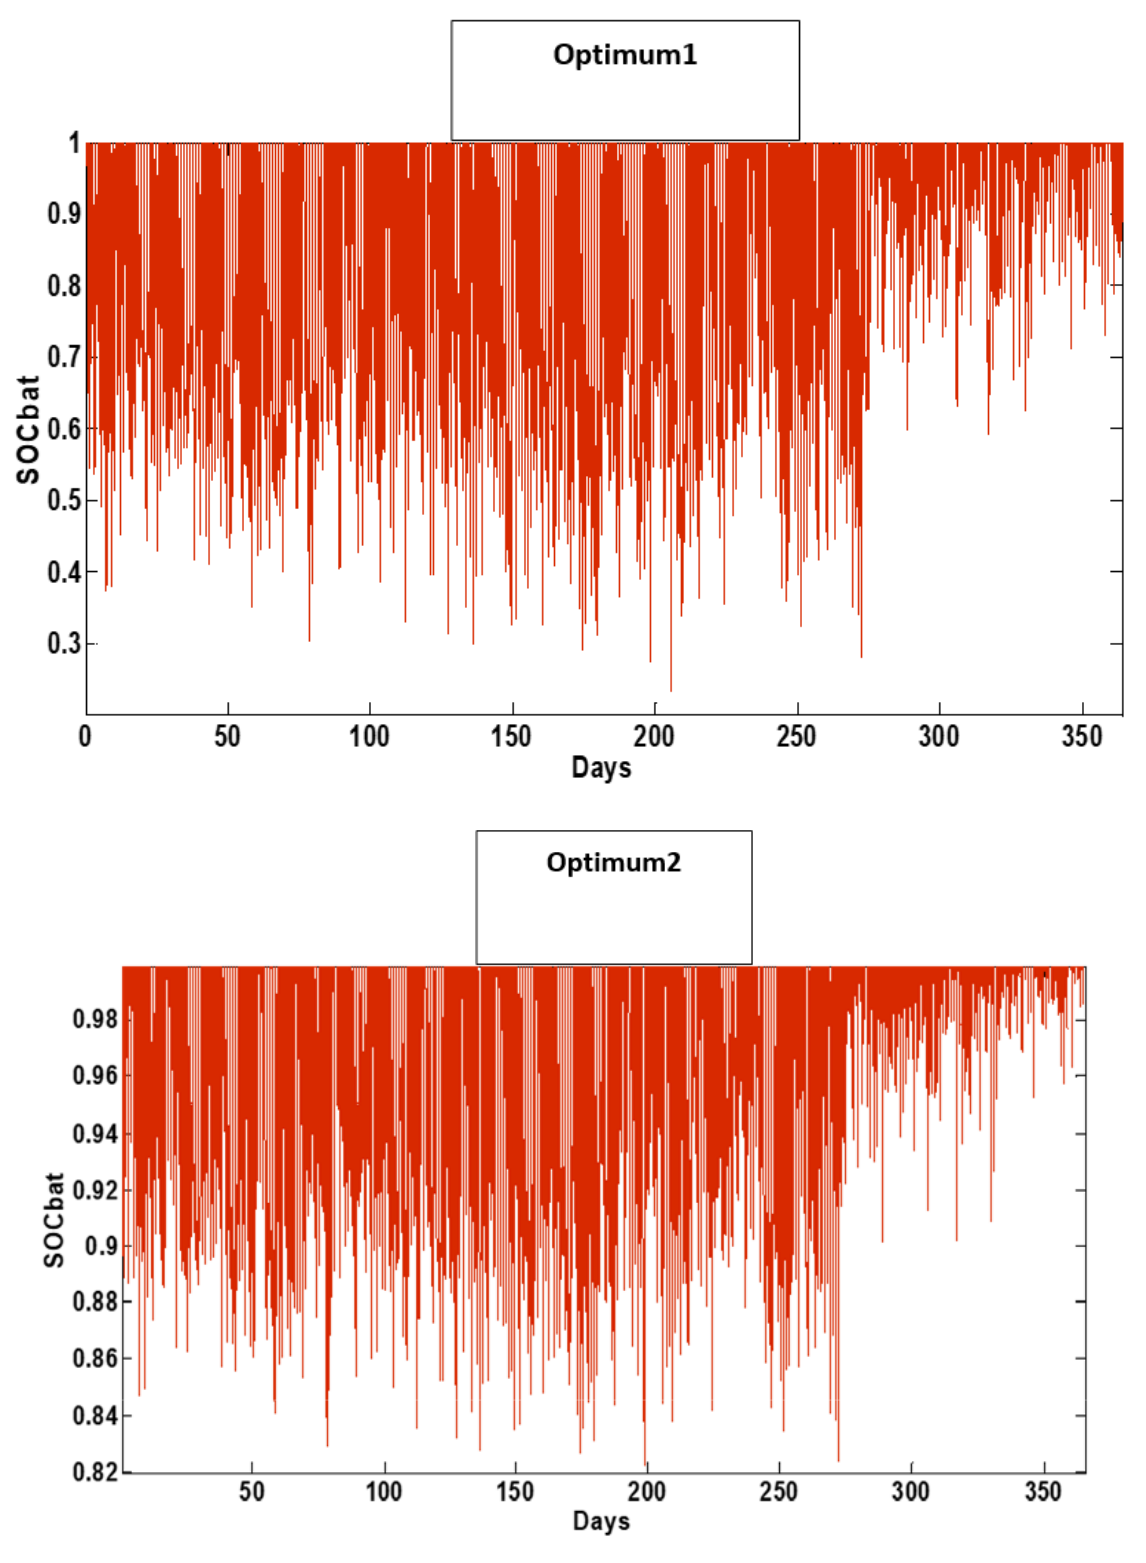
Figure 18. Battery SOCbat variations for configurations 1 and 2.